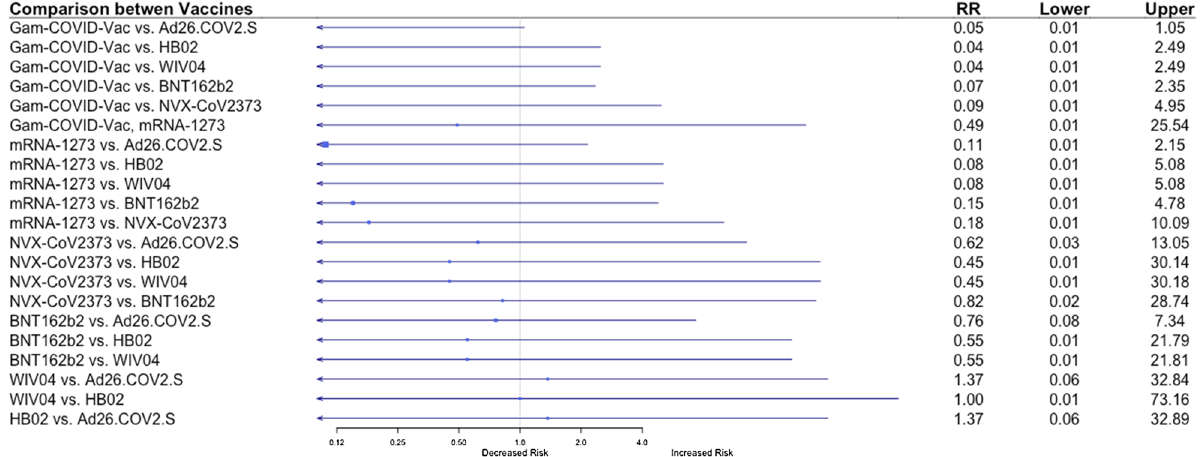
Figure 3. Results of random-effects network meta-analysis for efficacy to prevent severe COVID-19: Risk Ratio (RR) for indirect comparison between the vaccines or vaccine vs. placebo, and 95% confidence intervals (Five studies